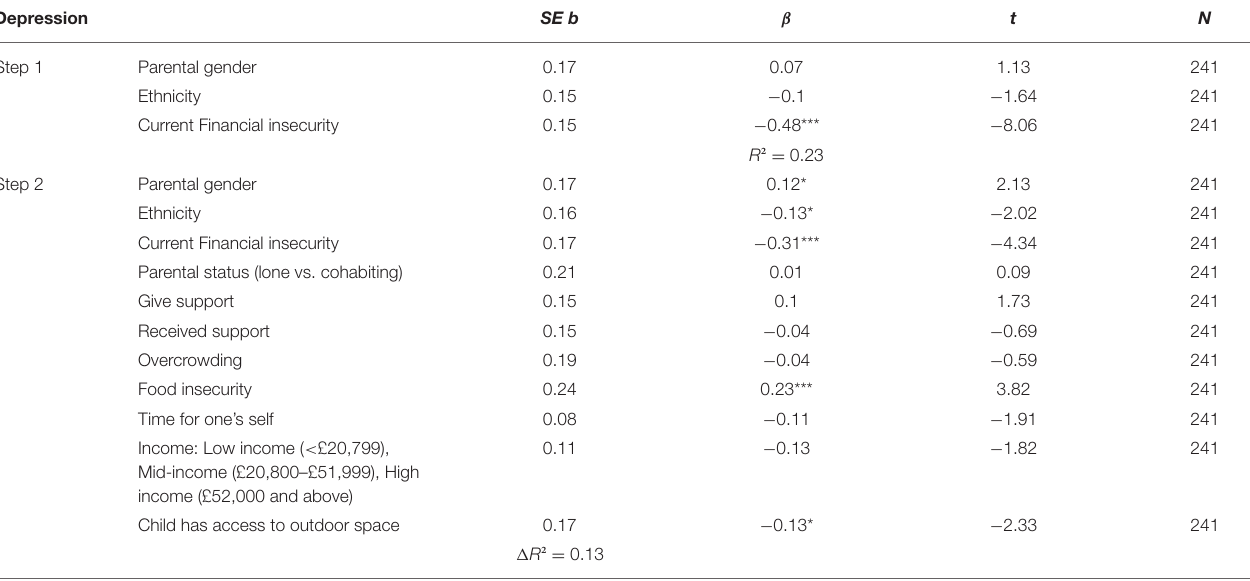
TABLE 3 | Hierarchical regression analyses predicting symptoms of depression.